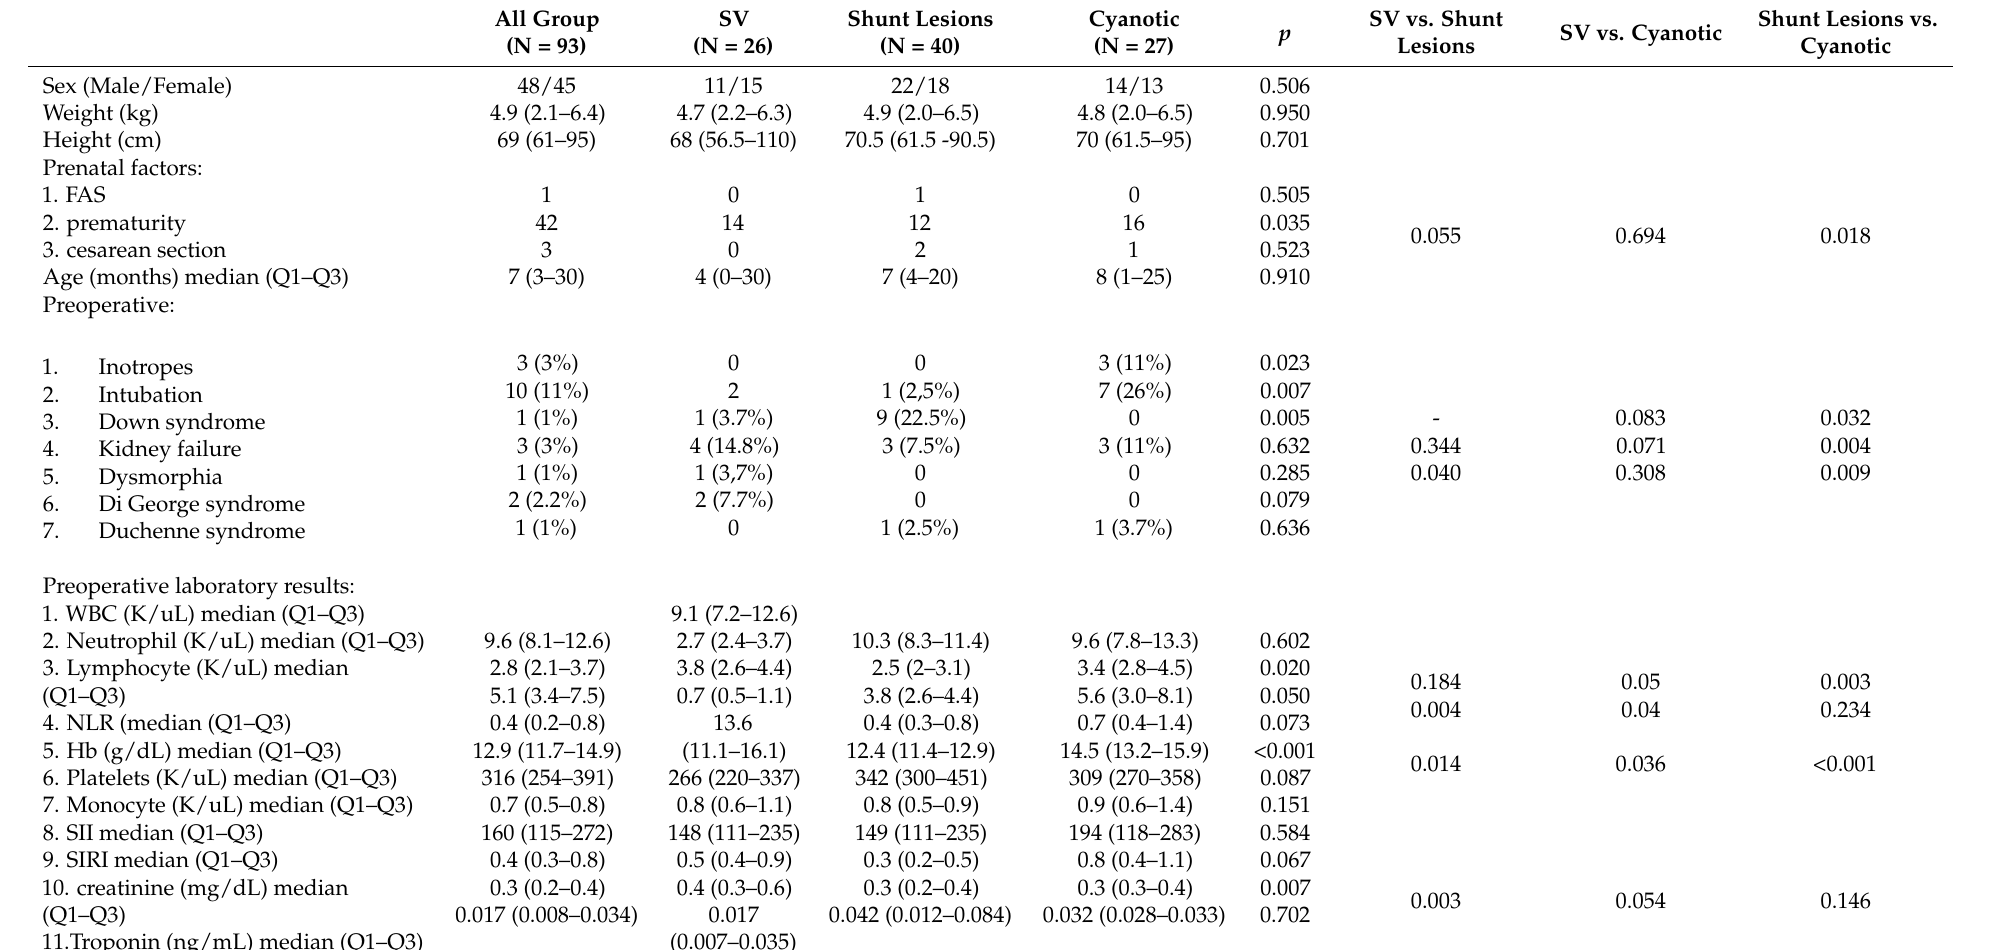
Table 4. Demographical and clinical